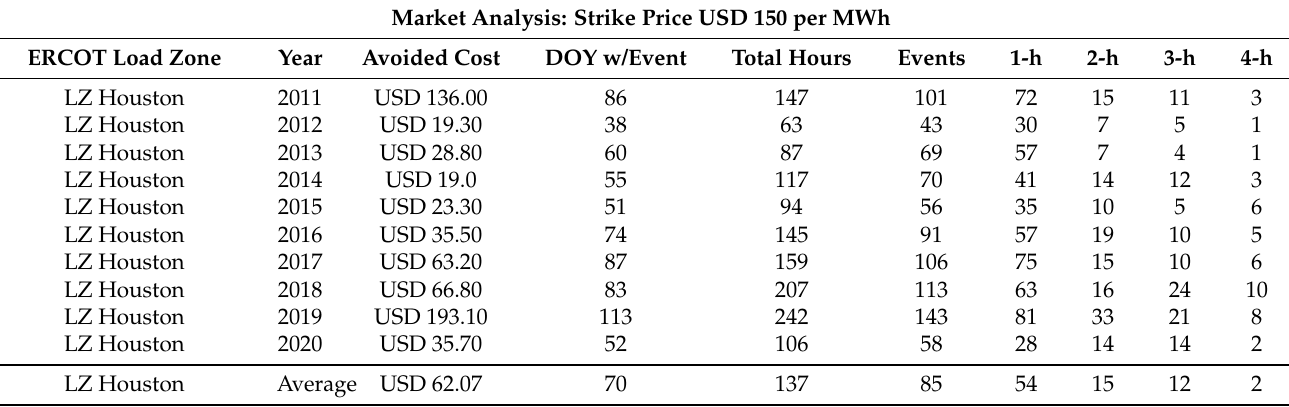
Table 1. Annual avoided cost of a load-shifting program deployed in ERCOT assuming a USD 150 per MWh strike price. Market Analysis: Strike Price USD 150 per MWh ERCOT Load